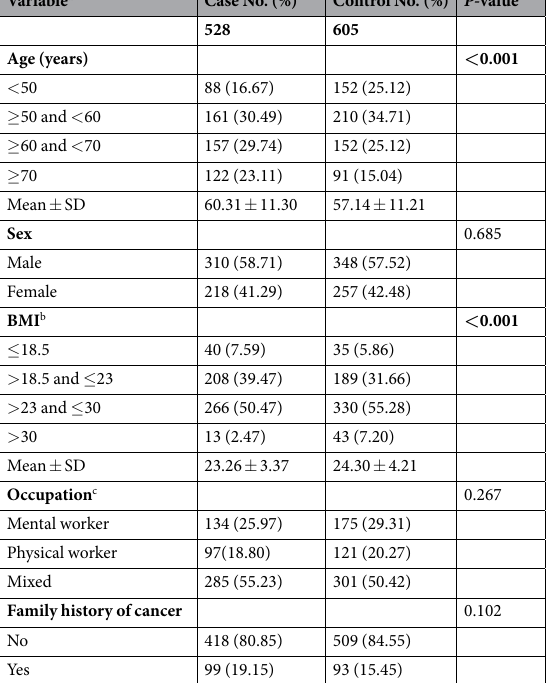
Table 1. Demographic characteristics of study subjects. a Missing data: occupation, 4 cases; BMI, 1 case, 8 controls; family history of cancer, 11 cases, 3 controls. b BMI, body mass index (weight/height 2 ). c Occupation: mental worker (white-collar worker) is the person who perform professional, managerial, or administrative work, such as civil servants, administrative management, scientific research, or education. Physical worker is the person whose job requires manual labor, such as farmer in our